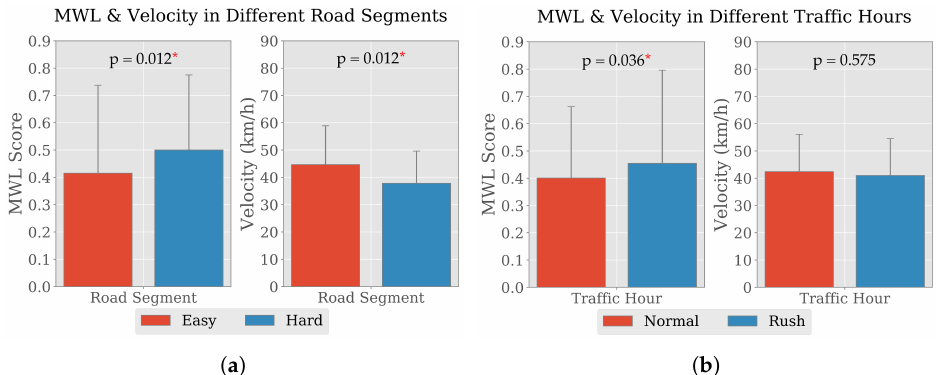
Figure 2. Average Mental Workload (MWL) score and velocity of nine participating drivers in different ( a ) Road segments and ( b ) traffic hours. The standard deviations are indicated, the p -values obtained from the two-sided Wilcoxon signed-rank tests are presented and significant values at 5% confidence interval are marked with asterisks (*).